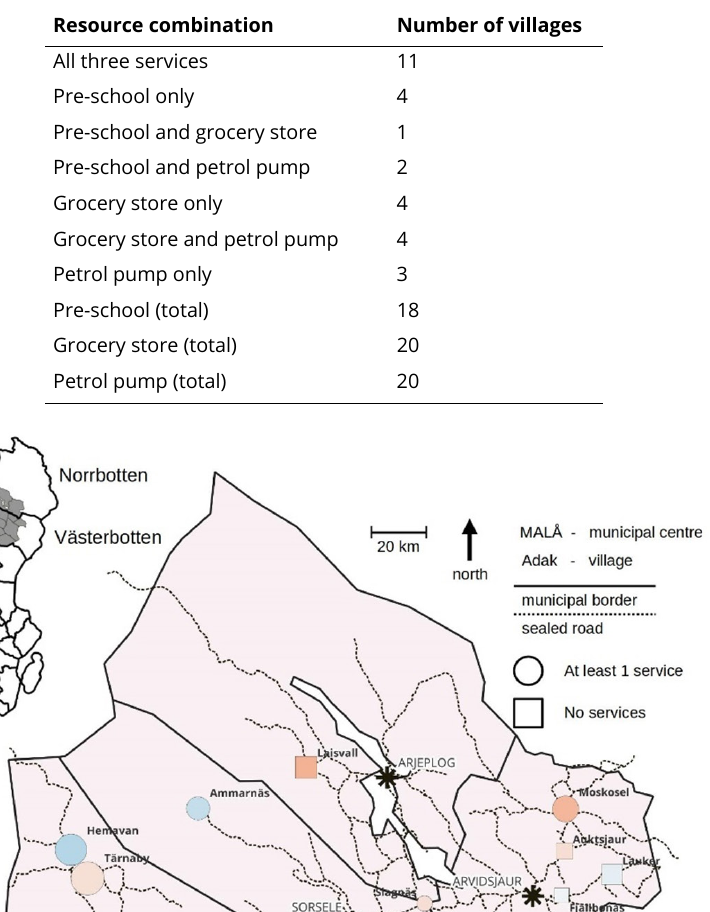
Table 1. Number of villages with resource combinations.